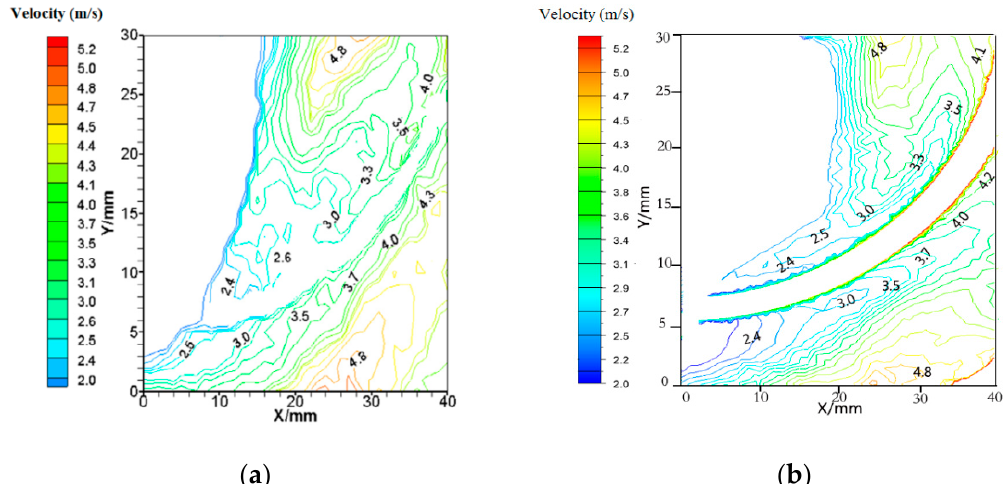
Figure 4. Comparison of the velocity fields in the case of clean water between the PIV and CFD results. ( a ) PIV result obtained from; ( b ) CFD result.